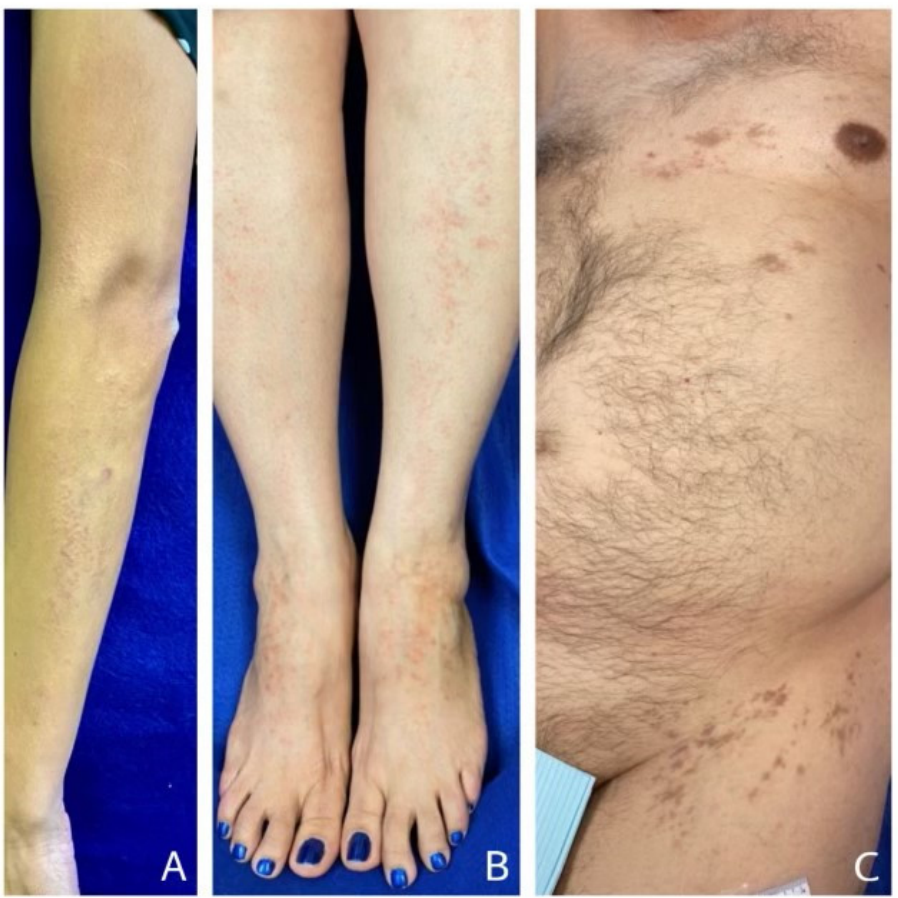
Figure 4. COVID-19 vaccine-induced lichenoid eruptions (V-ILEs) distributed in Blaschko’s lines. ( A ) unilaterally on the left forearm (case 1), ( B ) bilaterally on the anterior aspect of legs (case 2) and ( C ) unilaterally on the left side of chest, abdomen and proximal thigh (case 3). Histopathologic examination (Figure 5A,B) revealed a poorly defined lichenoid reac- tion with effacement of the dermo-epidermal junction. A patchy perivascular and interstitial infiltrate extended to mid dermis. The infiltrate extended diffusely through the epidermis which showed necrotic keratinocytes throughout with focal parakeratosis and